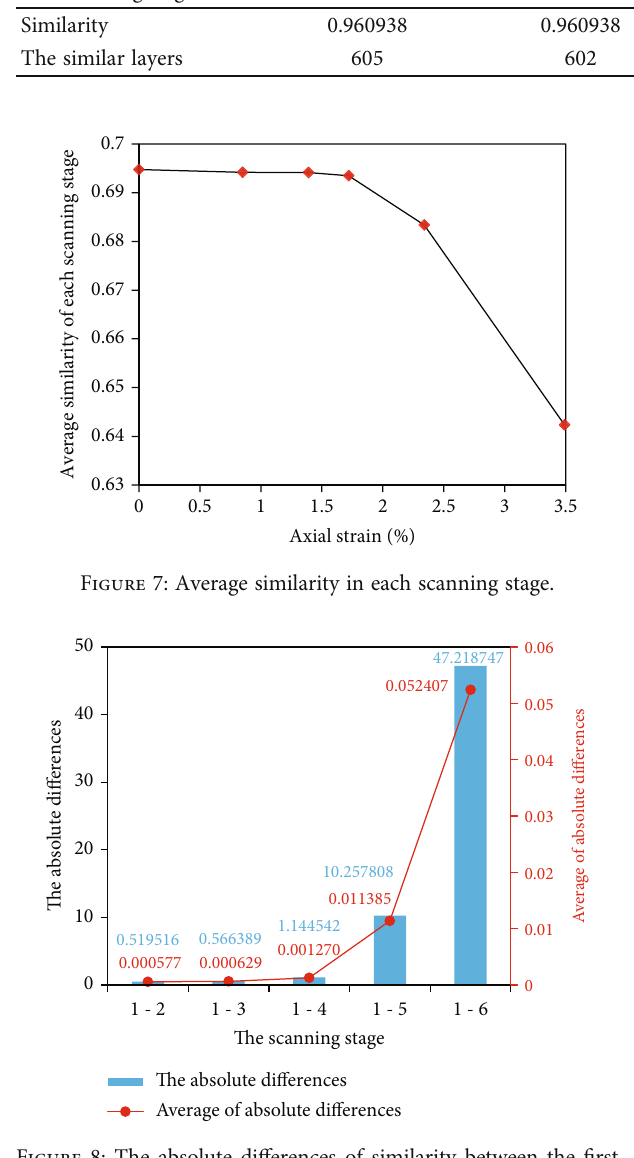
Figure 8: The absolute di ff erences of similarity between the fi rst scan and other